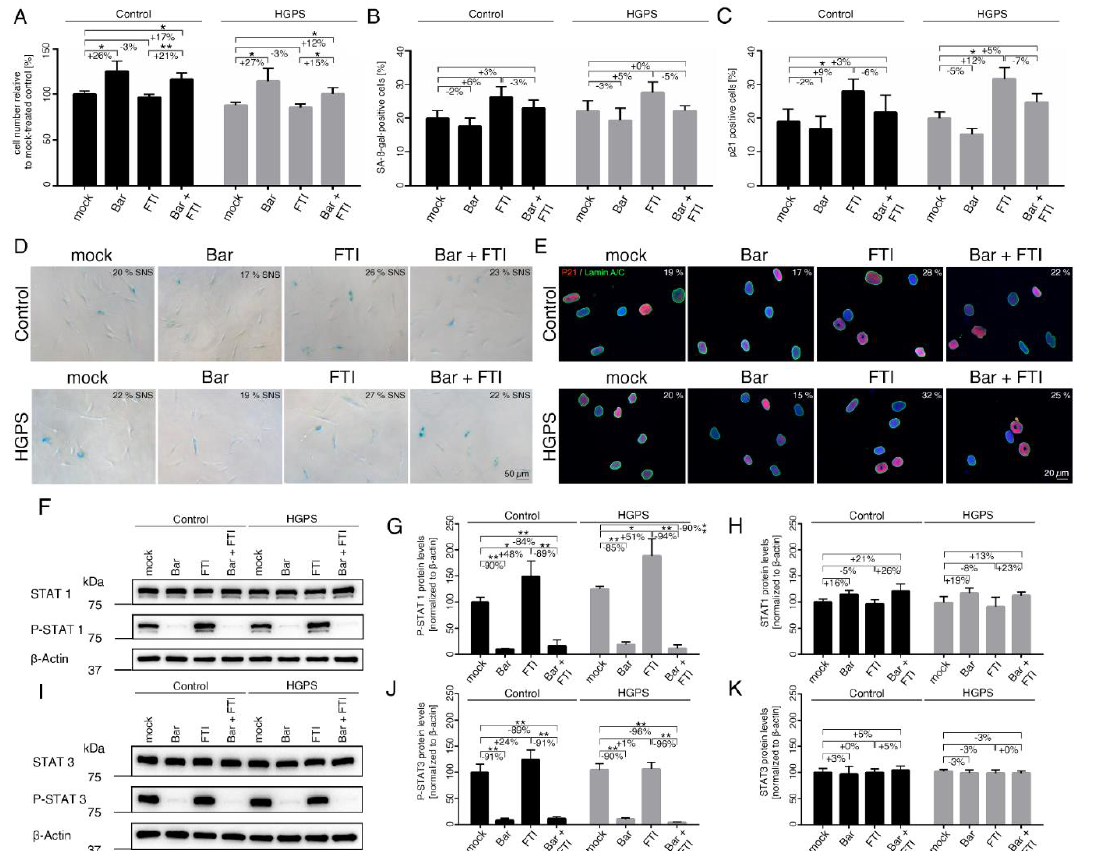
Figure 1. Replicative senescence of control and HGPS fibroblasts after treatment with baricitinib and FTI. ( A ) Cell numbers relative to mock-treated control cells. All cultures were started with ~15% senescence. Cells were either treated with vehicle (DMSO), Bar (1 µ M), FTI (0.025 µ M), or combined drugs for a period of nine days. ( B ) Graph shows the percentage of SA-ß-gal-positive cells measured after indicated treatments. ( C ) Percentage of cells positive for p21 after indicated treatment. ( D ) Representative images of SA-ß-gal-positive cells in treated cultures. Scale bar: 50 µ m. ( E ) Representative immunofluorescence images of control GM01651C and HGPS HGADFN127 fibroblasts after the indicated treatment. Antibodies against p21 (red) and lamin A/C (green) were used, and DNA was stained with DAPI. Fluorescence images were taken at 40 × magnification. Scale bar: 20 µ m. ( F , I ) Representative images of western blots for STAT1, P-STAT1, STAT3 and P-STAT3. Quantification of P-STAT1 ( G ), STAT1 ( H ), P-STAT3 ( J ), and STAT3 ( K ). Graphs show mean ± SD. Representative images are shown ( n = 3; * p < 0.05, ** p < 0.01)